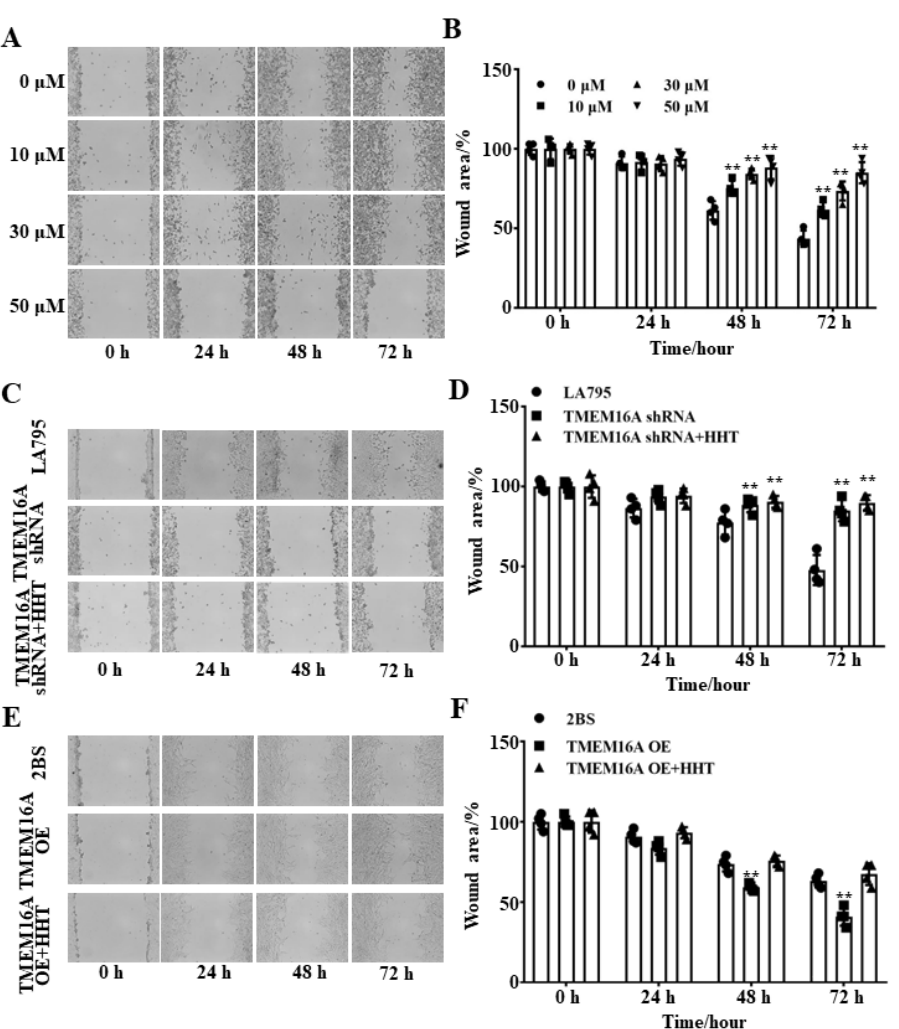
Figure 5. HHT inhibited lung cancer cell migration through inhibited TMEM16A. ( A ) Inhibitory effect of different concentrations of HHT on LA795 cell migration at 0, 24, 48 and 72 h ( n = 3). ( B ) Statistical results of ( A ) (** p < 0.01). ( C ) The LA795 cell migration before and after shRNA transfection at 0, 24, 48 and 72 h ( n = 3). ( D ) Statistical results of ( C ) (** p < 0.01). ( E ) The 2BS cell migration before and after TMEM16A transfection at 0, 24, 48 and 72 h ( n = 3). ( F ) Statistical results of ( E ) (** p < 0.01).